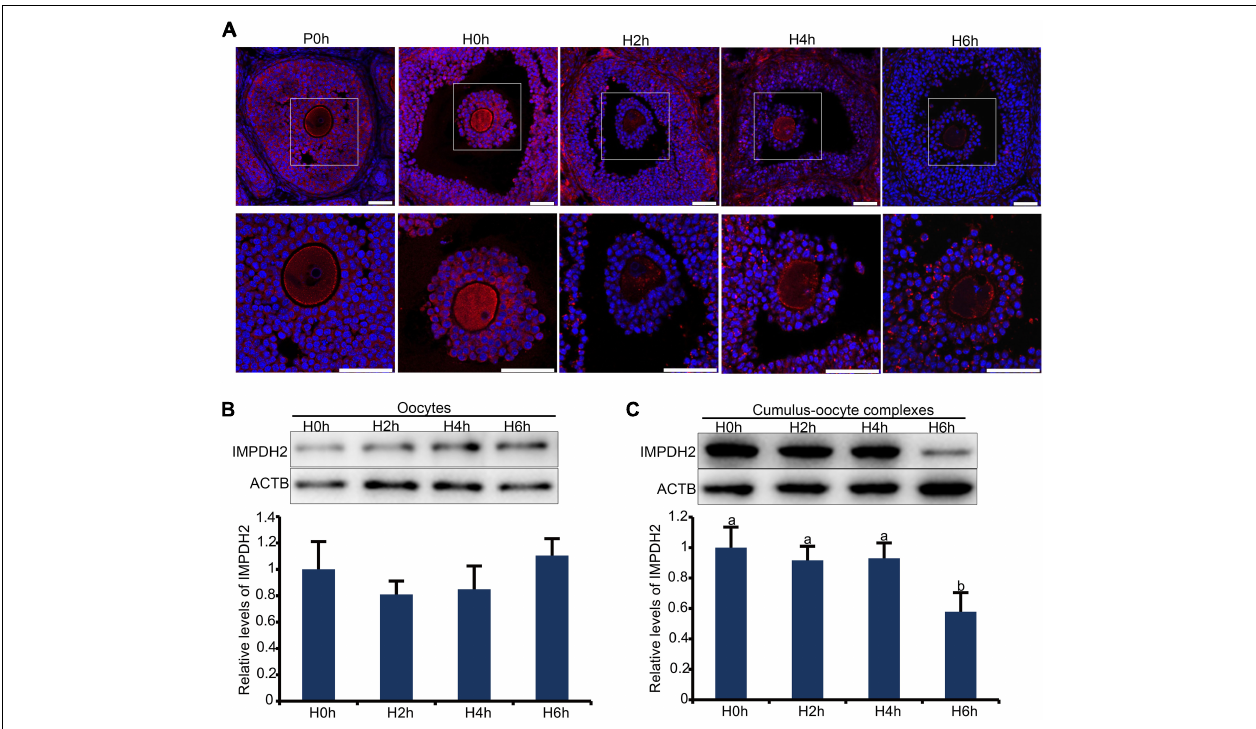
FIGURE 3 | Dynamic changes in the localization and expression of IMPDH2 protein in the oocyte and granulosa cells of the preovulatory follicles after in vivo administration of hCG to the mice. (A) IF staining of IMPDH2 protein in the ovary isolated from female mice that were not primed with eCG (P0h), primed with eCG for 48h but no hCG (H0h), and primed with eCG for 48 h followed by hCG for 2h (H2h), 4h (H4h), and 6h (H6h), respectively. Magnified view of the boxed area in the top panels is shown at the bottom. IMPDH2 is stained in red, and DNA is counterstained in blue. Scale bars represent 100 µ m. (B , C) WB detection of the expression of IMPDH2 protein in the oocytes and cumulus-oocyte complexes isolated from ovarian follicles of female mice that were primed with eCG for 48 h but no hCG (H0h), and primed with eCG for 48 h followed by hCG for 2h (H2h), 4h (H4h), and 6h (H6h), respectively. Quantification of the WB results is shown in the bottom bar graphs, bars without letters in common are considered significantly different ( P <